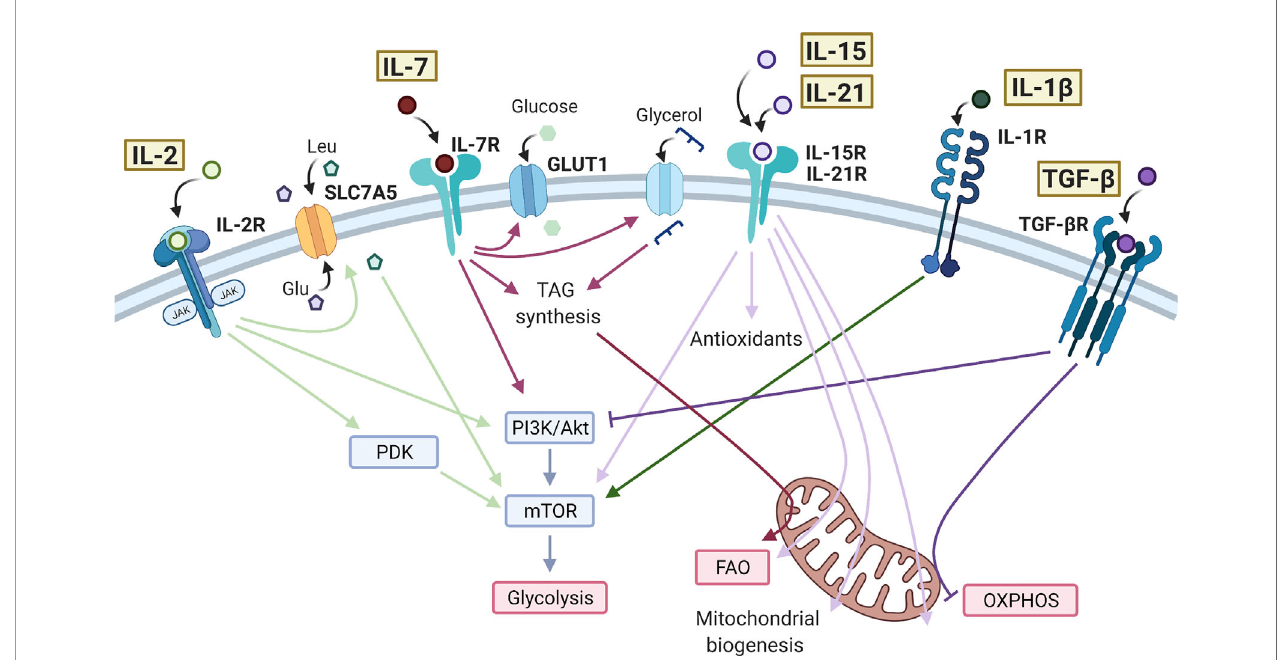
FIGURE 1 | Effects of cytokine signaling on T cell metabolism. IL-2 bound to the IL-2 receptor (IL-2R) is able to promote the activity of mTOR through PDK in CD8 + T cells and PI3K/Akt in CD4 + T cells. IL-2 promotes the expression of SLC7A5 at the cell surface leading to in fl ux of amino acids, further promoting the activity of mTOR and glycolysis. IL-7 also signals through the PI3K/Akt/mTOR pathway, as well as promoting GLUT1 expression to sustain glycolysis. In CD8 + memory T cells, IL-7 increases glycerol uptake and triacylglycerol (TAG) synthesis to enhance fatty acid oxidation (FAO). IL-15 and IL-21 have very similar action in promoting antioxidant production, FAO, mitochondrial biogenesis, and oxidative phosphorylation (OXPHOS) in T cells. IL-15 and IL-21 have also been shown to increase mTOR activity in CD8 + memory T cells and Tregs, respectively. IL-1 b drives mTOR activity and glycolysis in CD4 + T cells, typically promoting a Th17 cell phenotype. The anti-in fl ammatory cytokine TGF- b inhibits glycolysis in CD4 + T cells via the PI3K/Akt/mTOR pathway and inhibits OXPHOS in CD4 + memory T cells. Created with